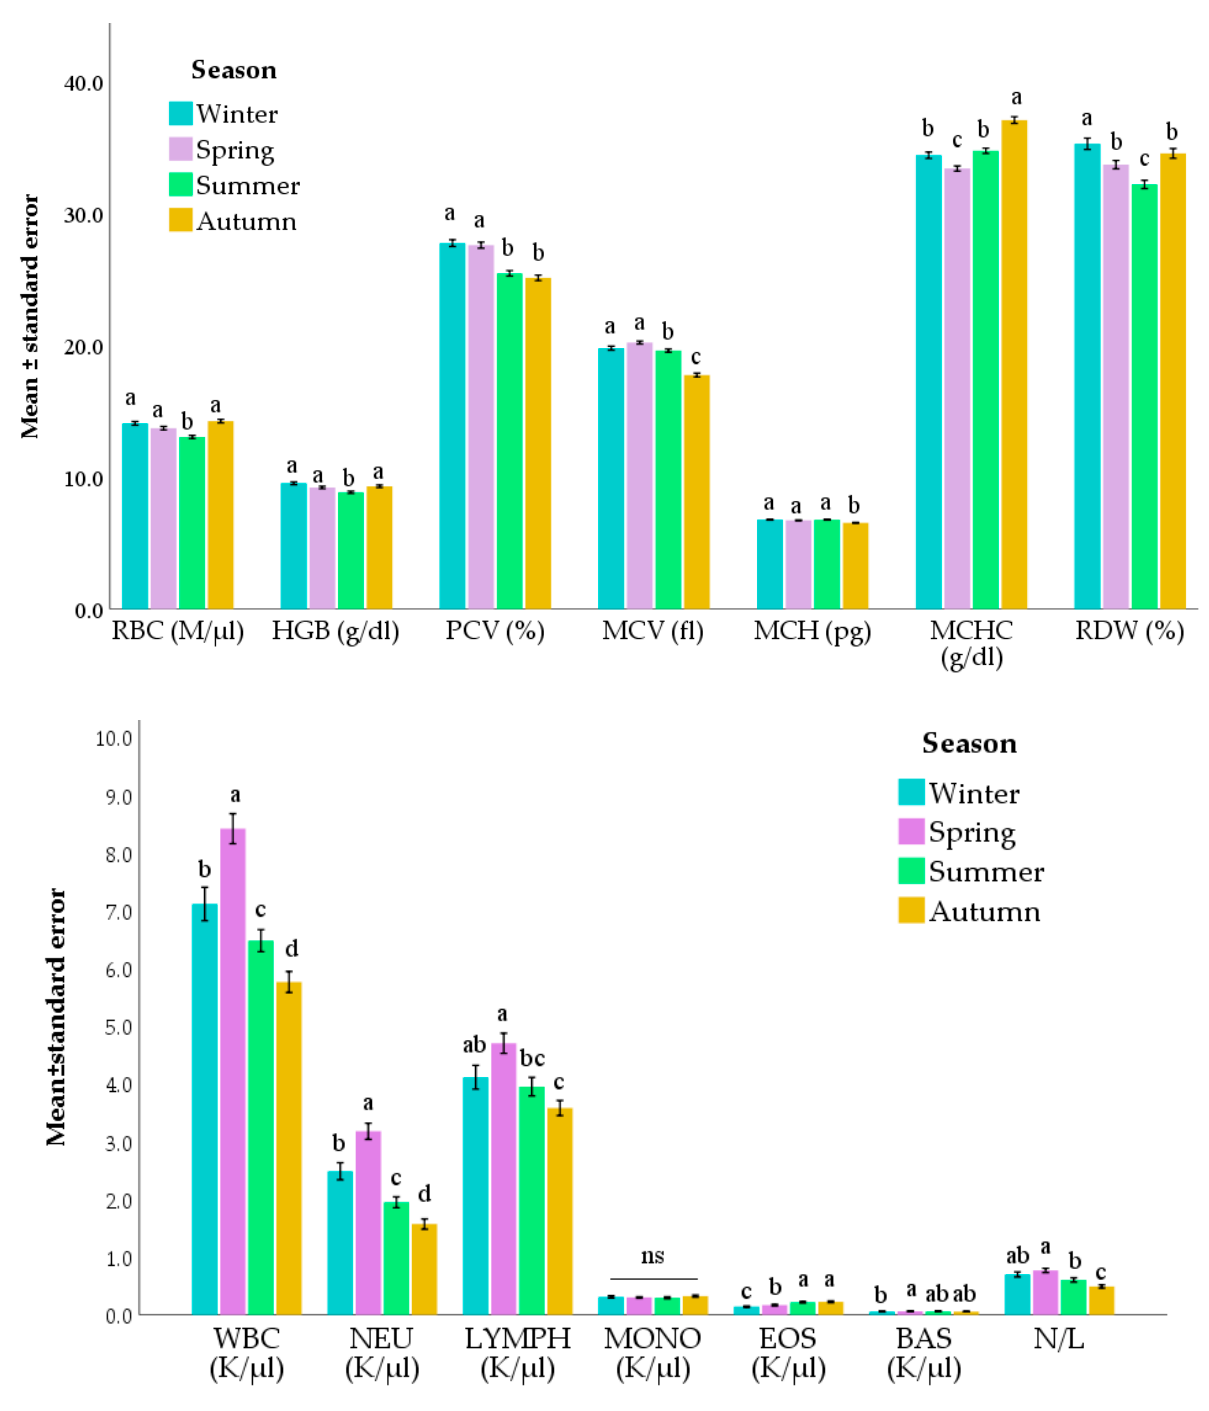
Figure 3. Main effect of season on the evaluated parameters. Values are means and standard errors. For each parameter, bars that do not share the same letter are significantly different ( p < 0.05; multiple comparisons with Sidak correction). Models also included Breed and Age (as covariate). RBC = red blood cells; HGB = hemoglobin; PCV = packed cell volume; MCV = mean corpuscular volume; MCH = mean corpuscular hemoglobin; MCHC = mean corpuscular hemoglobin concentration; RDW = red cell distribution width; WBC = leucocyte count; NEU = neutrophil count; LYMPH = lymphocyte count; MONO = monocyte count; EOS = eosinophil count; BAS = basophil count; N/L = neutrophils to lymphocytes